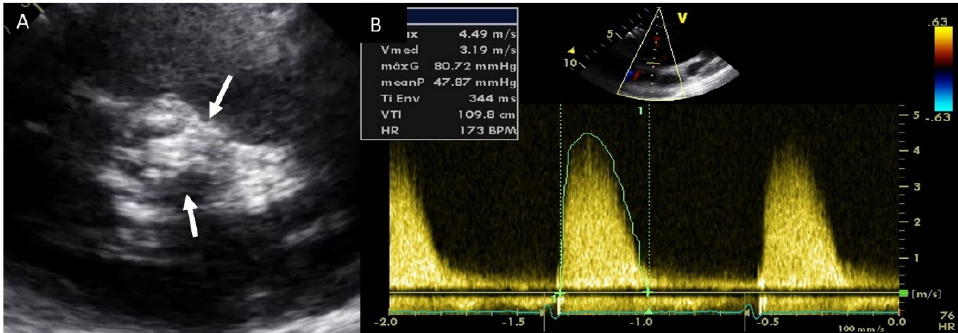
Figure 4. Severe aortic stenosis in BAV with severe calcification (arrows) ( A ); the mean gradient by continuous ‐ wave Doppler is 48 mmHg ( B ).